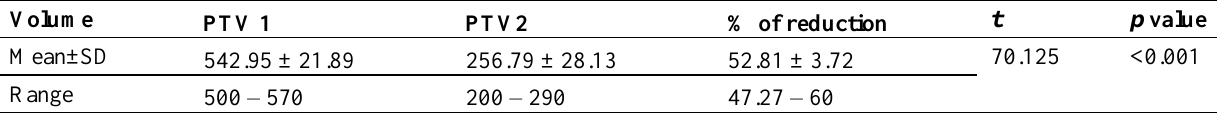
Table 2. Reduction in the planning treatment volume (PTV) for the 10 patients Volume